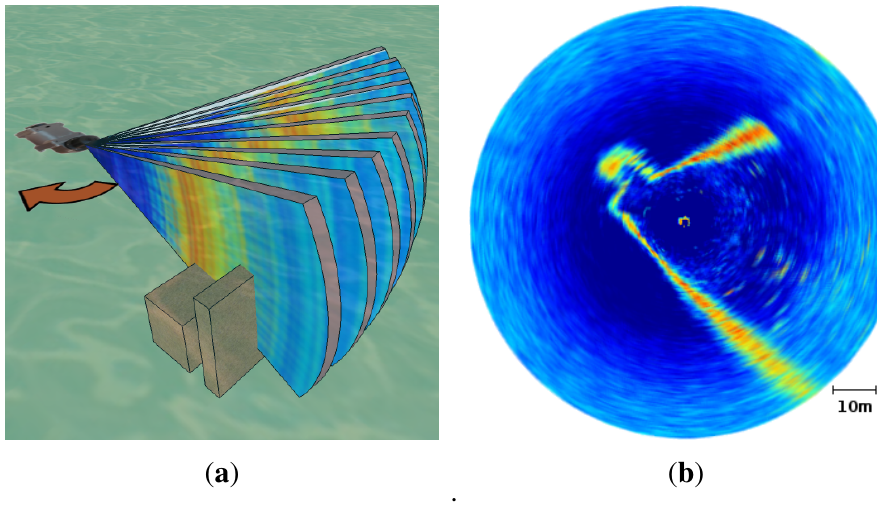
Figure 1. ( a ) Scanning process of an MSIS. The two boxes represent obstacles in the acoustic wave path; ( b ) Example of acoustic image. The colors depict the echo intensities, ranging from blue (low echo intensity) to red (high echo intensity).